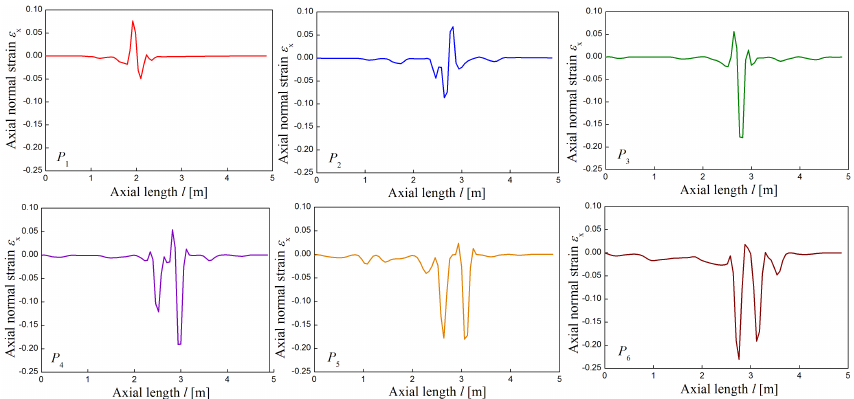
Figure 10. Variations of axial strain at the compression side of the buckling area in section D under different internal pressures.